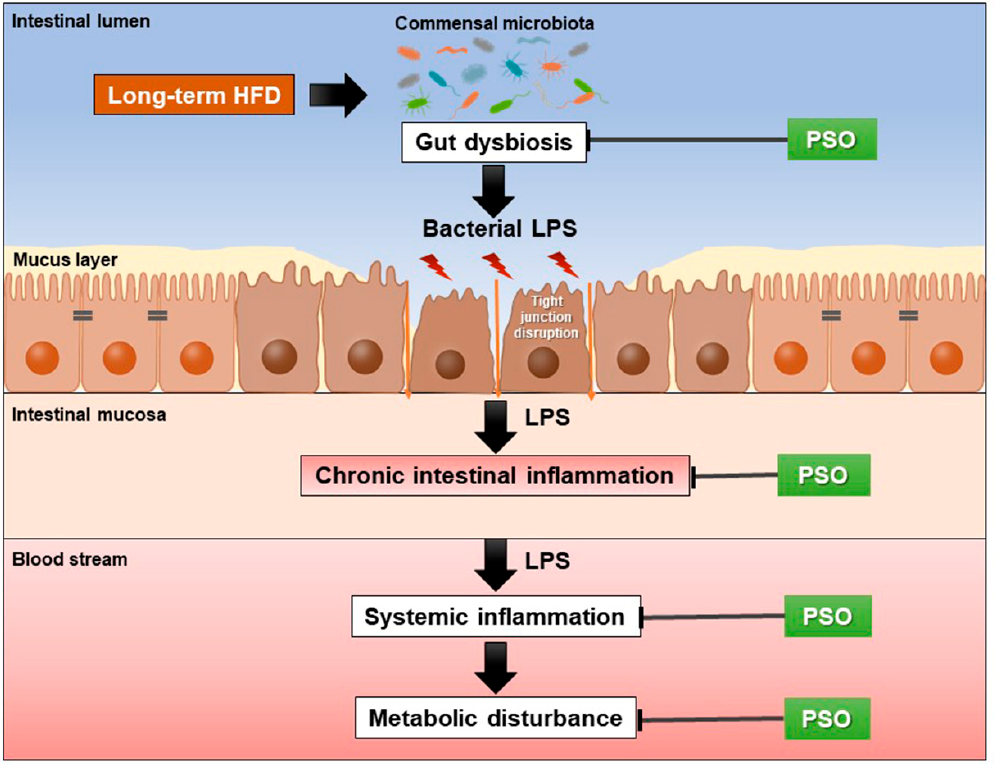
Figure 6. This schematic overview shows the effects of PSO treatment on obese-insulin-resistant rats. PSO alleviated HFD-induced gut dysbiosis, which results in decreased intestinal inflammation, systemic inflammation, and metabolic disturbance. HFD = high fat diet; LPS = lipopolysaccharide; PSO = perilla seed oil.